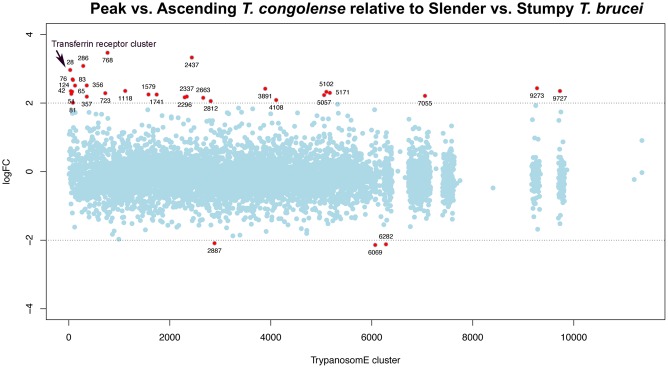
Comparative orthogroup regulation in T. congolense and T. brucei differences between mean Log2FC values for orthologous group expression in peak versus ascending parasitaemia T. congolense and stumpy versus slender T. brucei.A positive LogFC value indicates an orthologous group for which the fold change was greater for T. congolense ascending to peak parasitaemia than for T. brucei slender to stumpy differentiation, with a negative LogFC value indicating that the fold change was greater in the T. brucei samples. MCL TrypanosomE orthogroups showing at least 4-fold difference between species are shown in red.